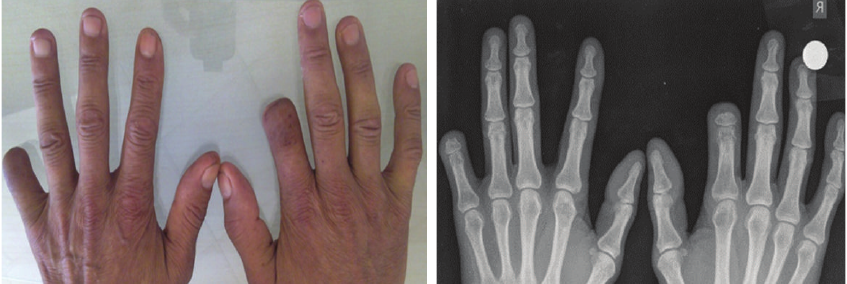
Figure 5: Clinical and radiographic images at postoperative 10th